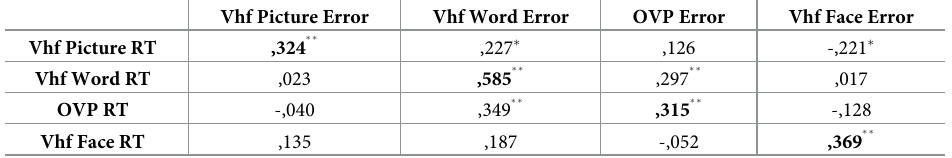
Table 4. Pearson correlations between reaction times and error rates for the four visual half field tasks. The speed-accuracy trade-off correlations per task are highlighted in bold. Vhf Picture Error Vhf Word Error OVP Error Vhf Face Error Vhf Picture RT ,324 �� ,227 � ,126 -,221 � Vhf Word RT ,023 ,585 �� ,297 �� ,017 OVP RT -,040 ,349 �� ,315 �� -,128 Vhf Face RT ,135 ,187 -,052 ,369 �� RT = reaction time; VHF = visual half field; OVP = Optimal Viewing Position. �� denote significant correlations at the 0.01 level (2-tailed) � denote significant correlations at the 0.05 level (2-tailed).